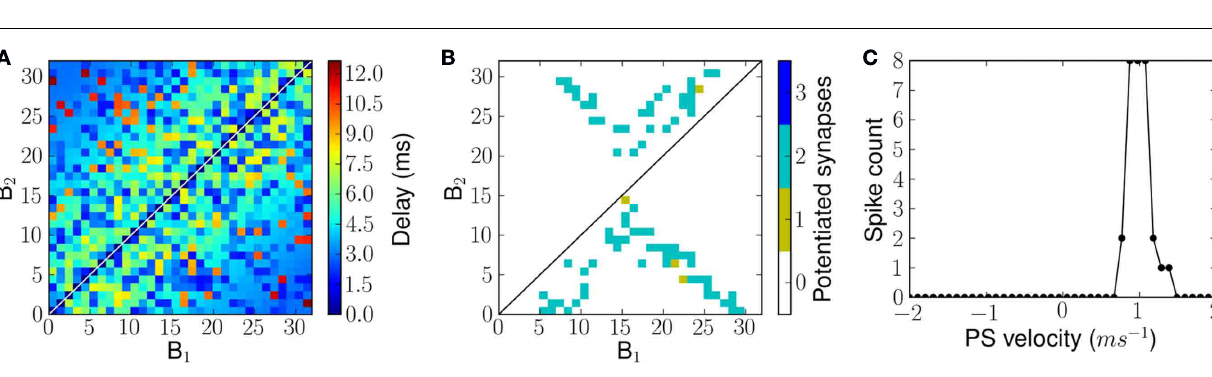
potentiated synapses per projection from a B 1 neuron to B 2 neuron after exposure to forked frequency sweeps of velocity 1.0ms − 1 . (C) The measured tuning curve of the network after